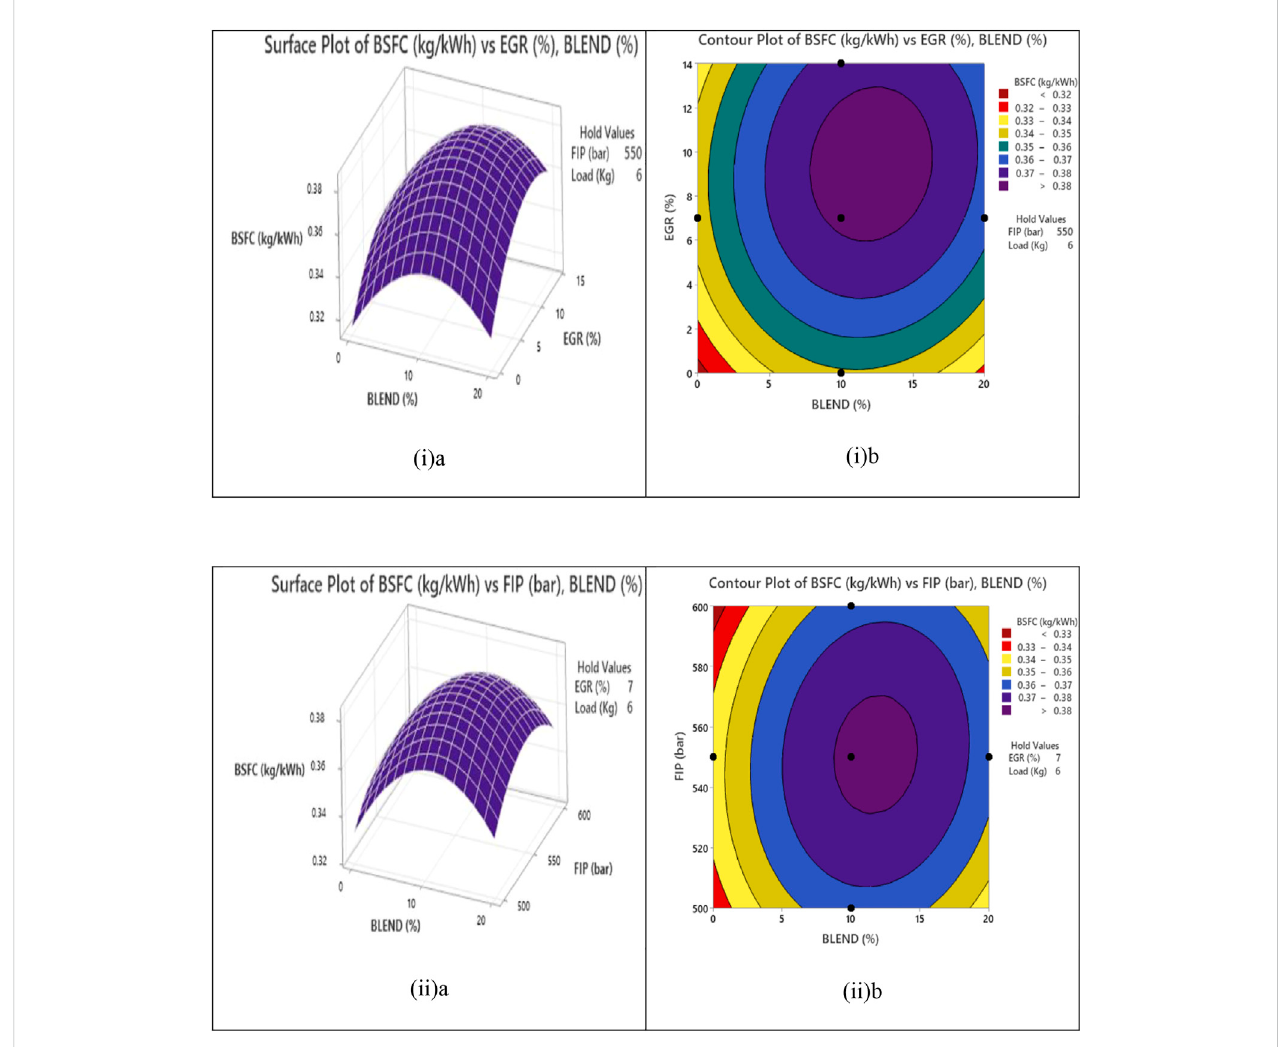
FIGURE 6 Effect of input factors on